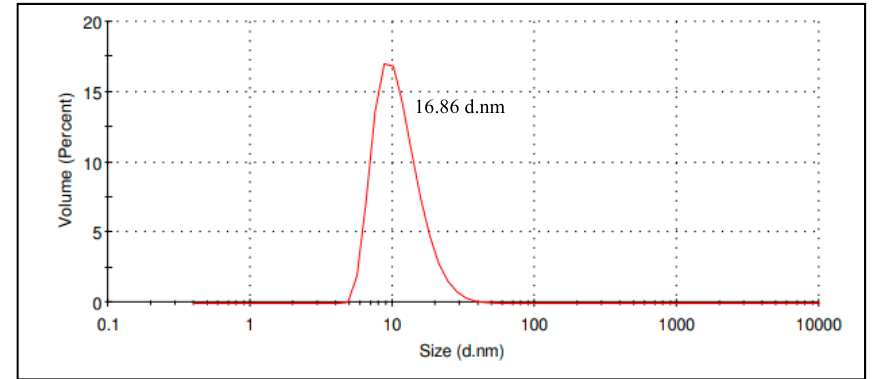
Figure 2. The particle size distribution of Citral-loaded self nano-emulsifying drug delivery system (CIT-SNEDDS ) obtained from the Malvern Instrument Report.